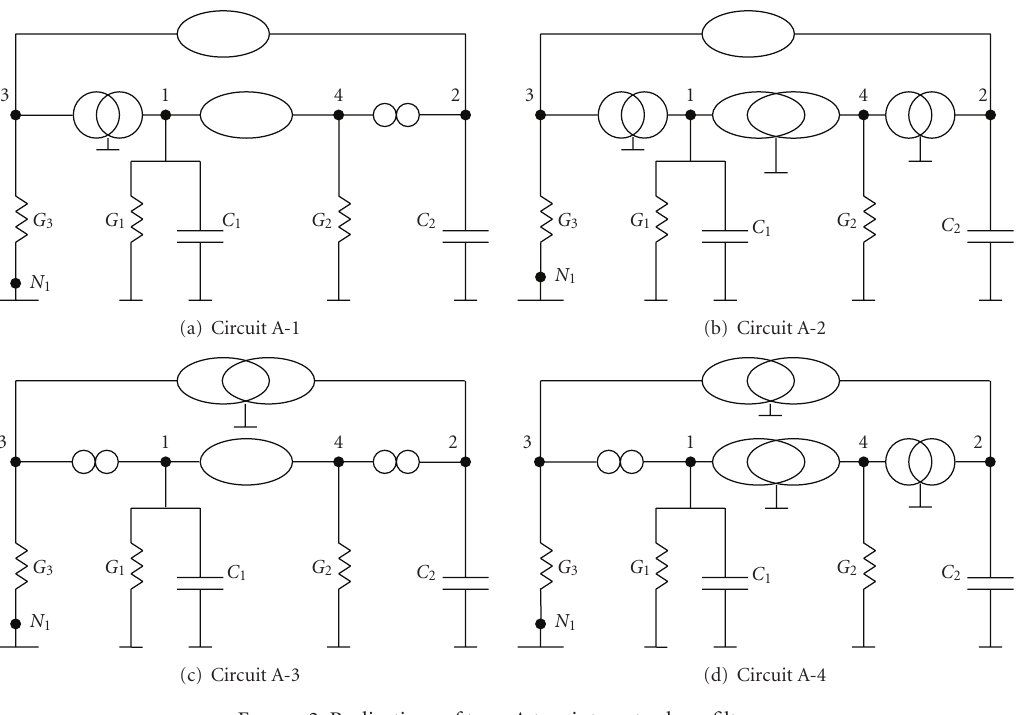
Figure 2: Realizations of type-A two integrator loop filters.